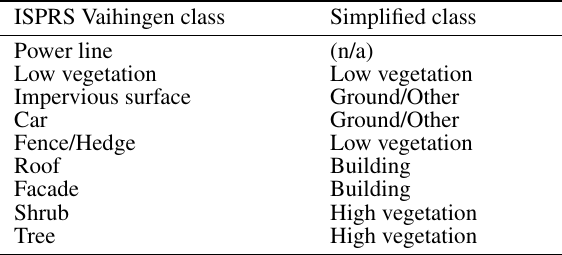
Table 1. ISPRS point cloud labels are mapped to mesh edge labels. Because of the mesh generation, a number of classes are collapsed to abstracted